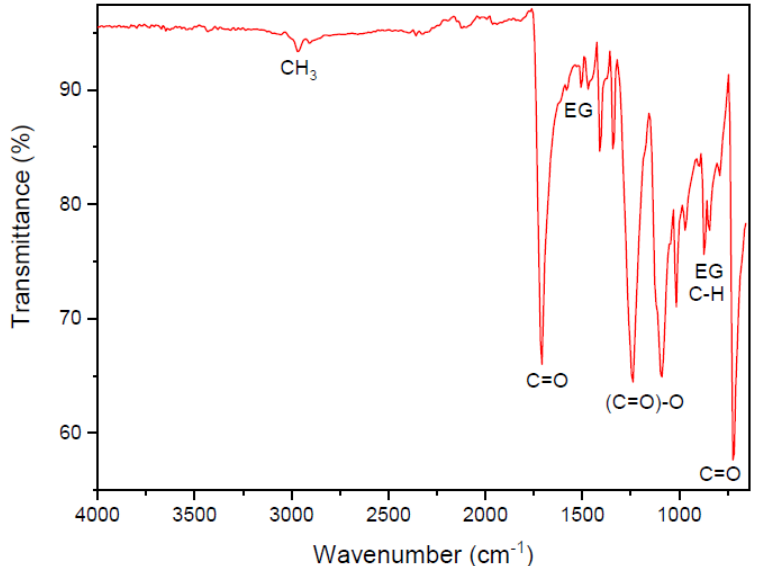
Figure 4. FTIR of the polyester textile.